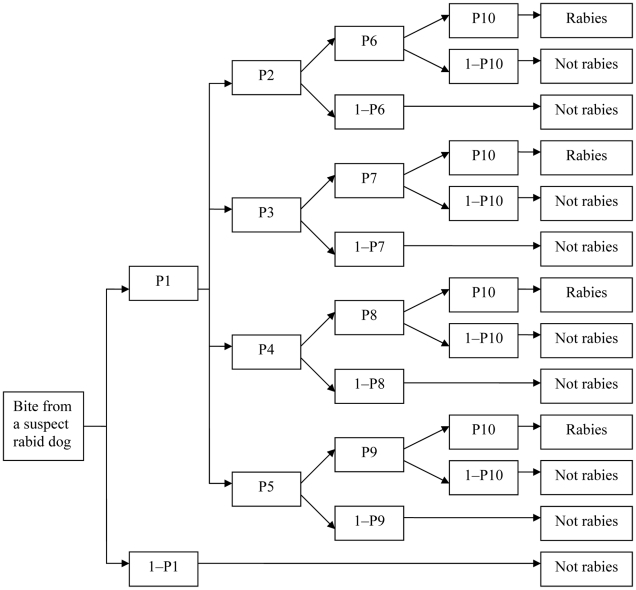
Decision tree model outlining the probability of rabies deaths.The model is adapted from Cleaveland et al., 2002 (reference number 11). Probabilities (P1–P10) are defined in Table 4 and described in the methods section. The probability calculated represents the probability of death following the bite of a suspect rabid dog.